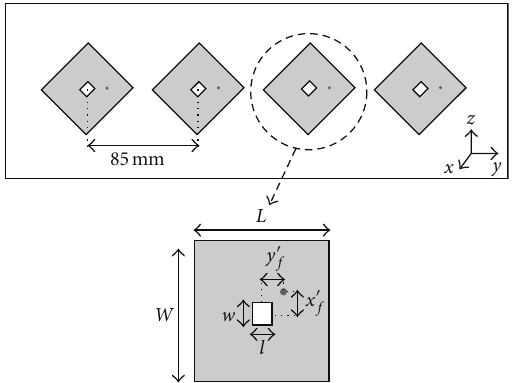
Figure 2: Geometry of the passive transmit array.